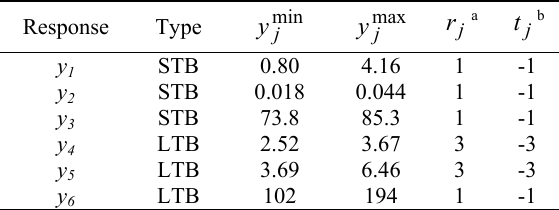
a Shape factors for Derringer-Suich desirability approach b Exponents for Kim-Lin desirability